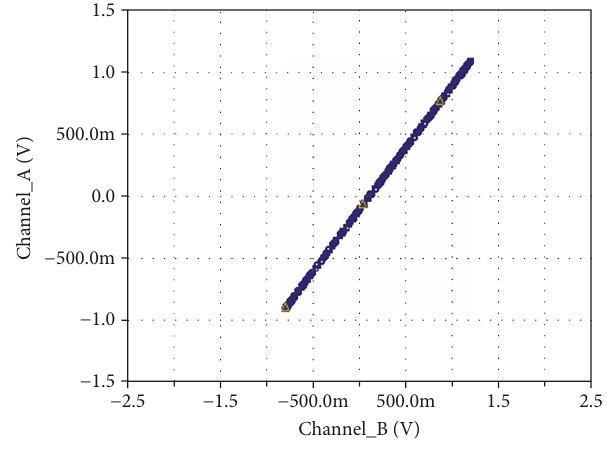
Figure 16: Synchronous phase portrait.